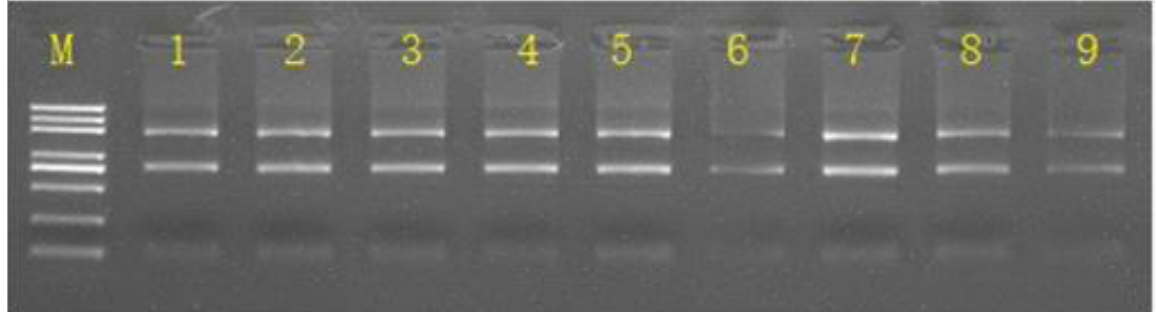
Figure 1. The gel electrophoresis diagram of total RNA from Vero cell. M: Marker; Line 1–3: The uninfected control group; Line 4–6: Infected with PEDV for 12 h; Line 7–9: Infected with PEDV for 24 h.